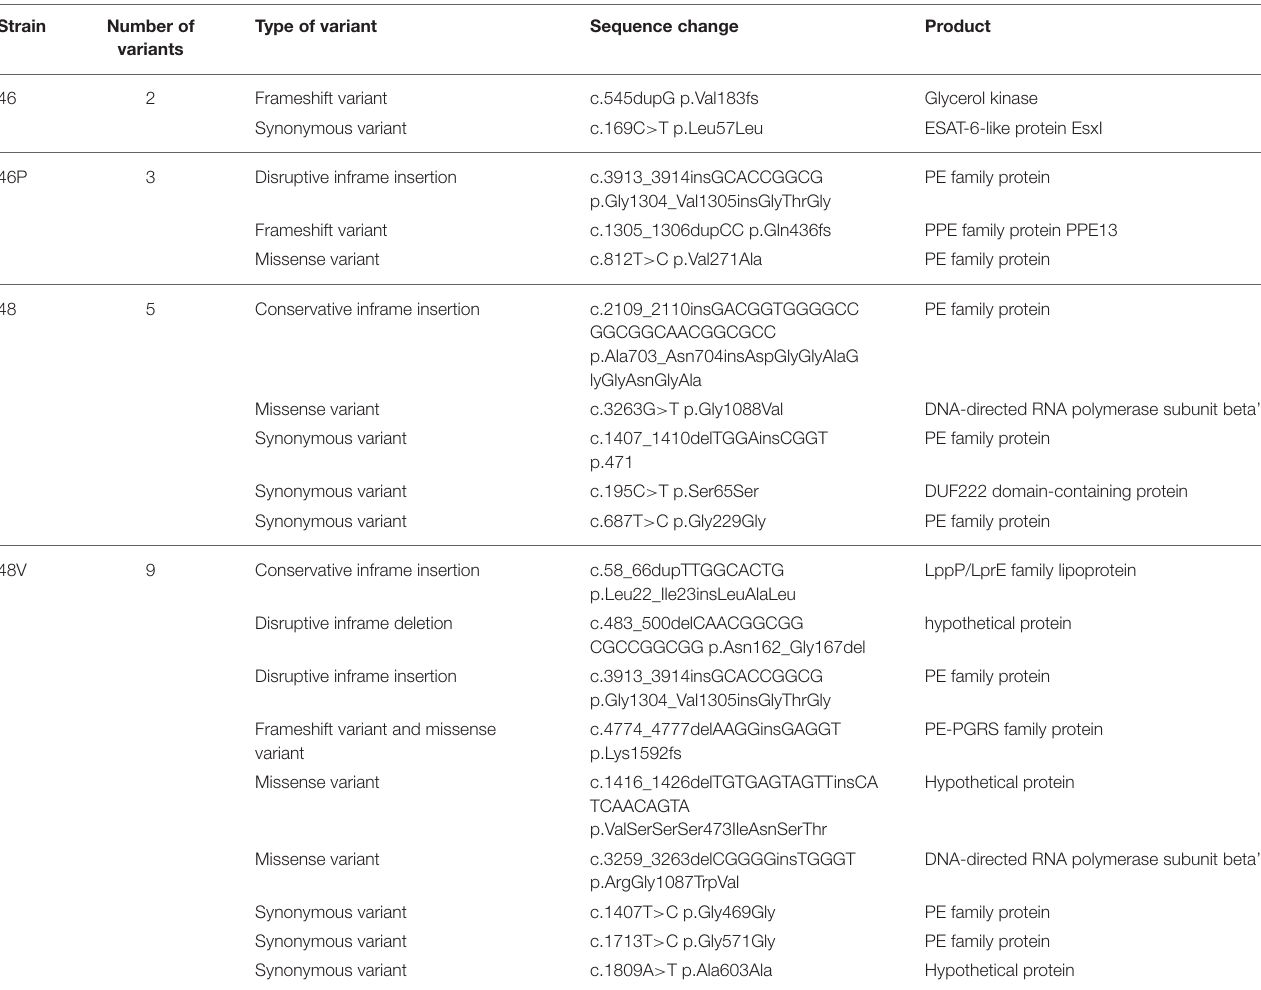
TABLE 2 | Genome variants present in Beijing genotype bacilli before and after passage through BCG-vaccinated mice.